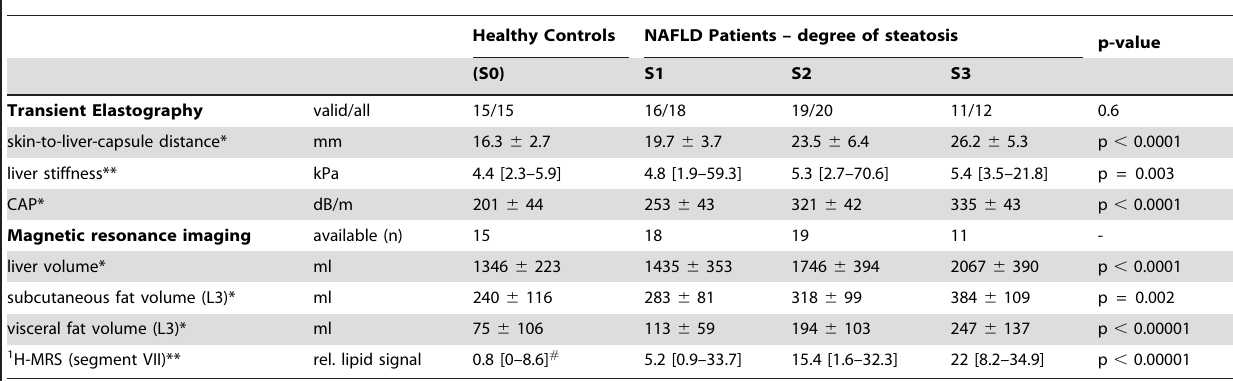
Table 2. Elastography, Controlled attenuation parameter (CAP) and magnetic resonance